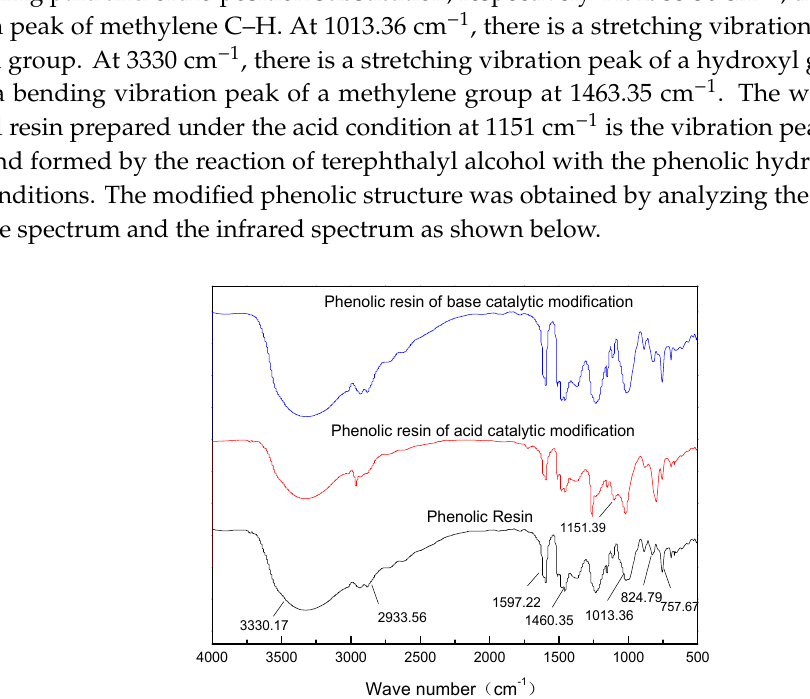
Figure 2. FTIR spectrum of phenolic resin and modified phenolic resin.